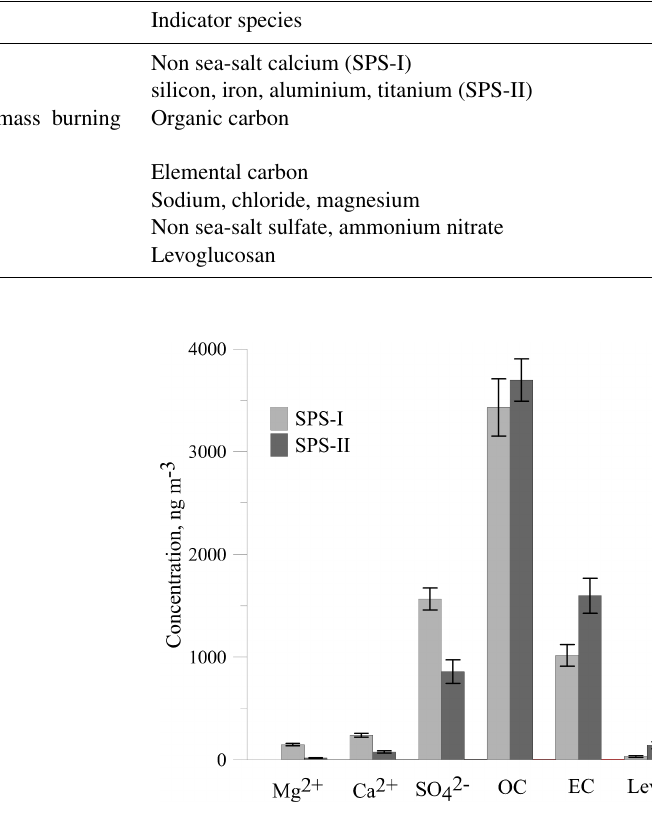
Figure 24. Scatter plot of Al and Si for SPS-II.